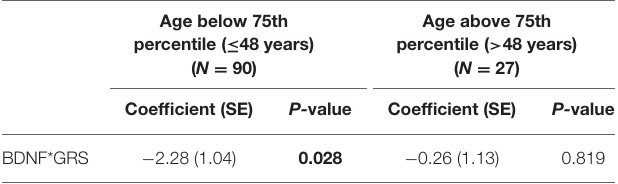
Individual models are stratified by age. a Covariates included in the model: GCS, cortisol (trajectory group). Bolded p-value indicates statistical